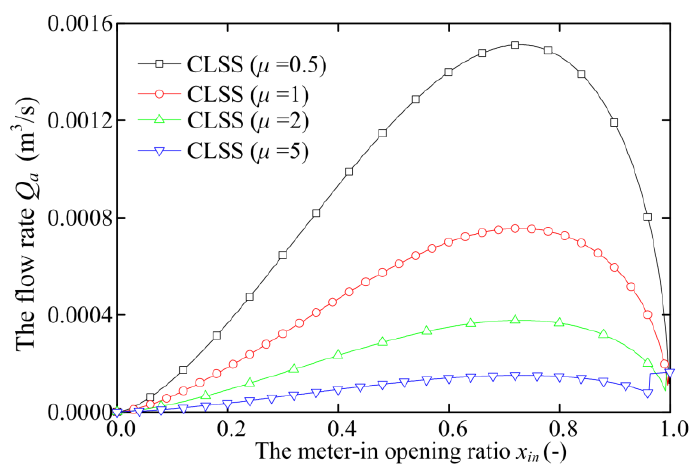
Figure 20. The flow rate Q a of the cylinder head chamber of CLSS with retraction working mode.